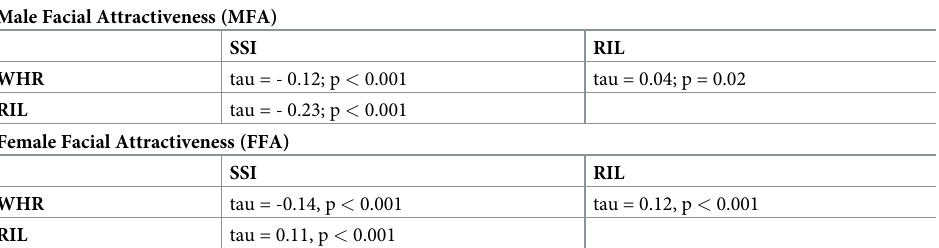
Table 1. Kendall correlation results between variables (z-scored) included in the models. Male Facial Attractiveness (MFA) SSI RIL WHR tau = - 0.12; p < 0.001 tau = 0.04; p = 0.02 RIL tau = - 0.23; p < 0.001 Female Facial Attractiveness (FFA) SSI RIL WHR tau = -0.14, p < 0.001 tau = 0.12, p < 0.001 RIL tau = 0.11, p <